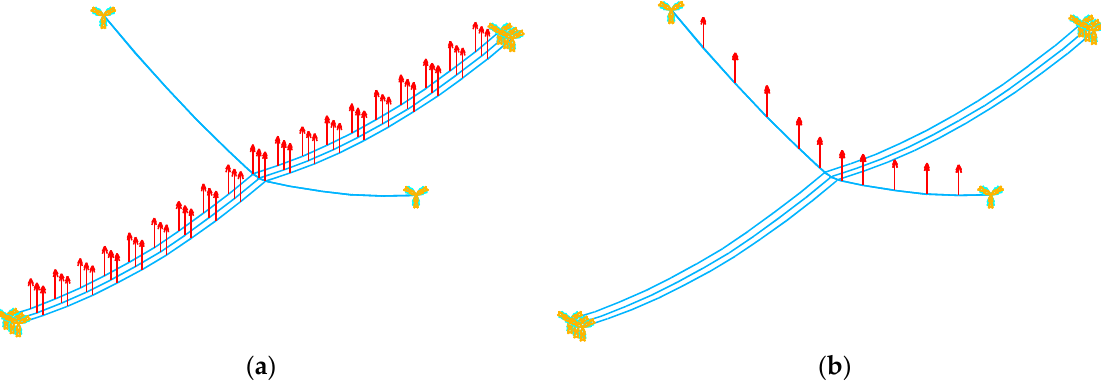
Figure 20. Typical wind lift loading mode in FE model of CRS (2 spans). ( a ) Conductor, ( b ) cable.